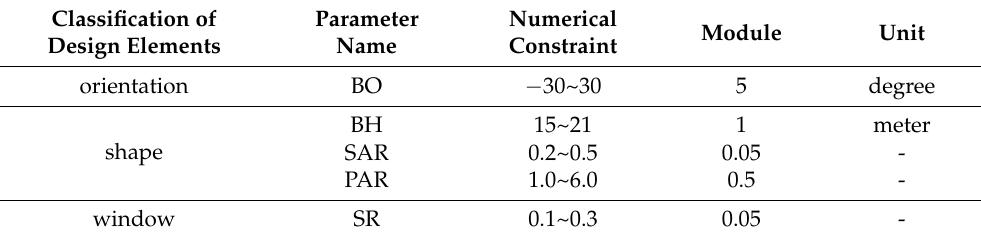
Table 1. Constraints of design parameters of light environment in waiting